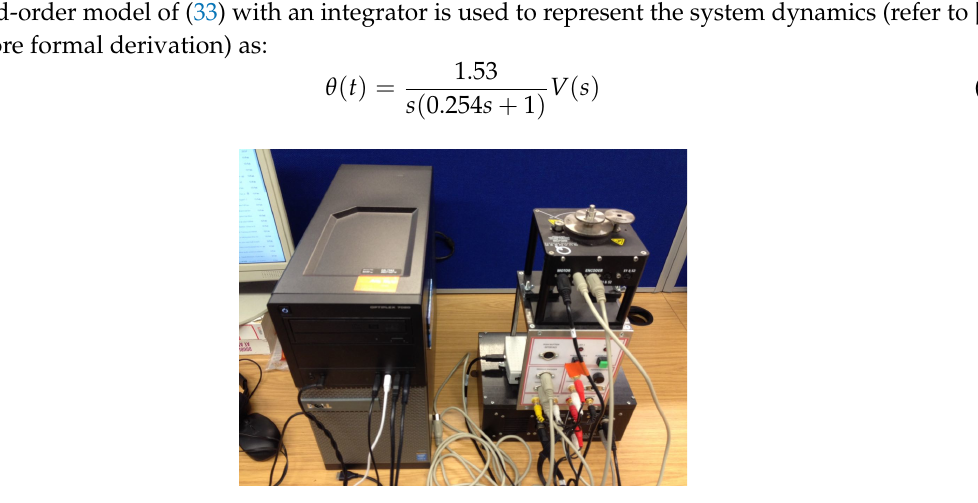
Figure 5. Quanser SRV02 servo based